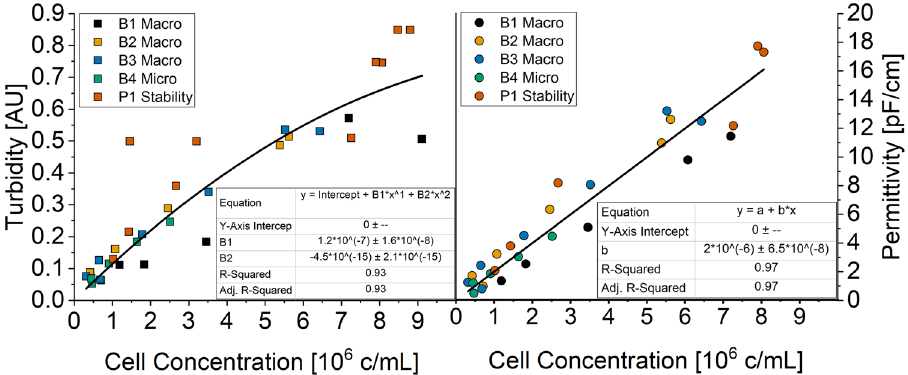
Figure 3. Cultivation data used to calculate the correlation between viable cell concentration and turbidity or permittivity. B1–3 = batch cultivations with macrosparger, B4 = batch cultivation with microsparger, P1 = perfusion stability